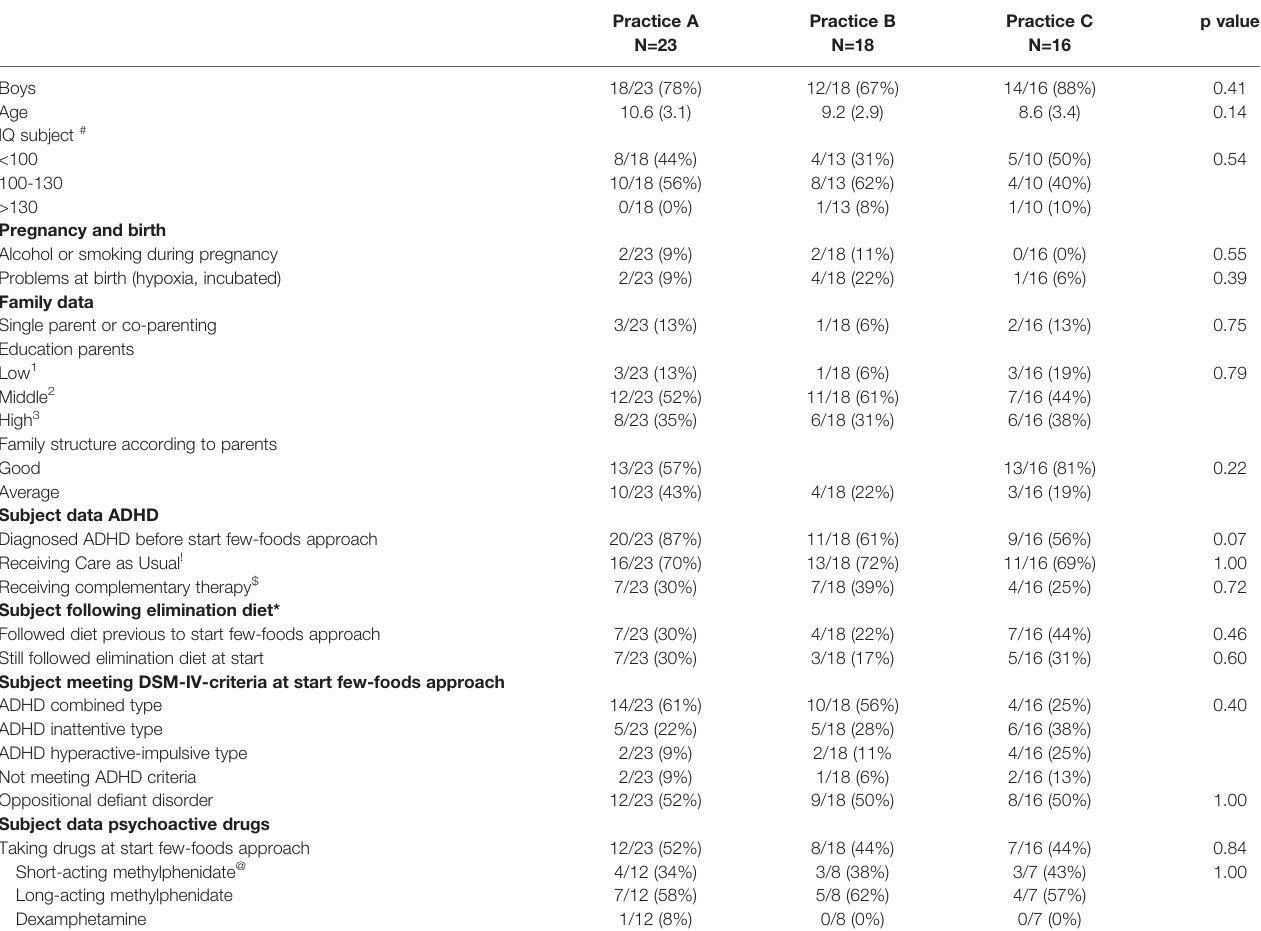
TABLE 1 | Baseline characteristics of the included subjects per